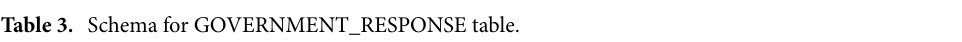
Table 3. Schema for GOVERNMENT_RESPONSE